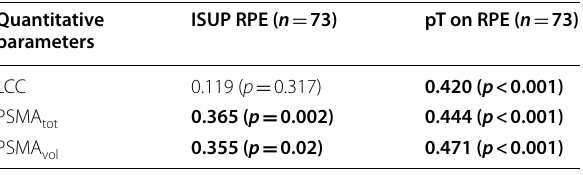
Statistically significant p -values are marked by bold font EPD extraprostatic disease, tot total, vol volume, LCC longest capsular contact